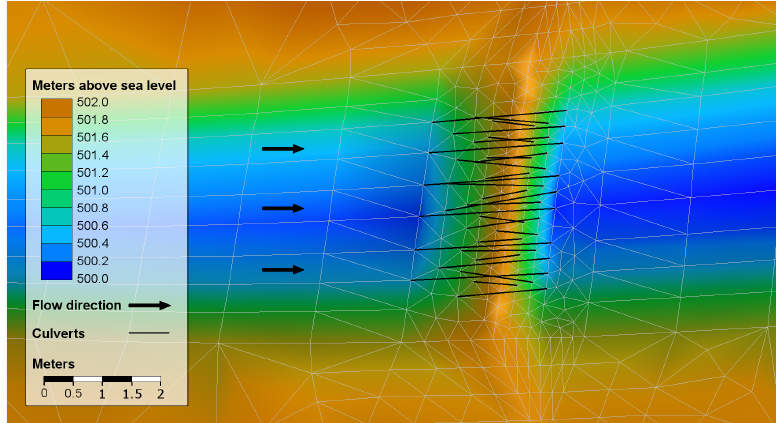
Figure 2. Schematic representation of a beaver dam in the numeric calculation mesh (plan view, hillshade